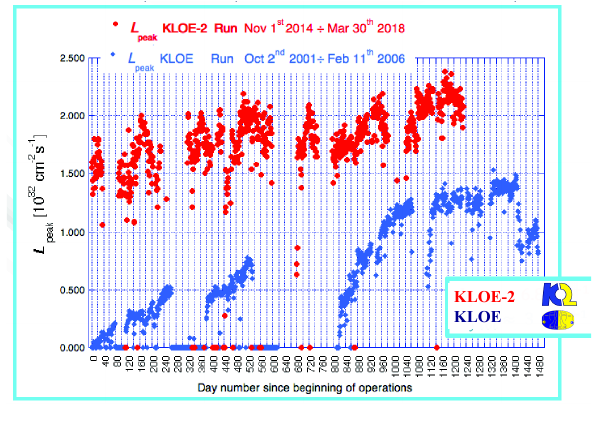
Figure 1. Comparison of the DA Φ NE peak luminosity for KLOE and KLOE-2 data-taking.